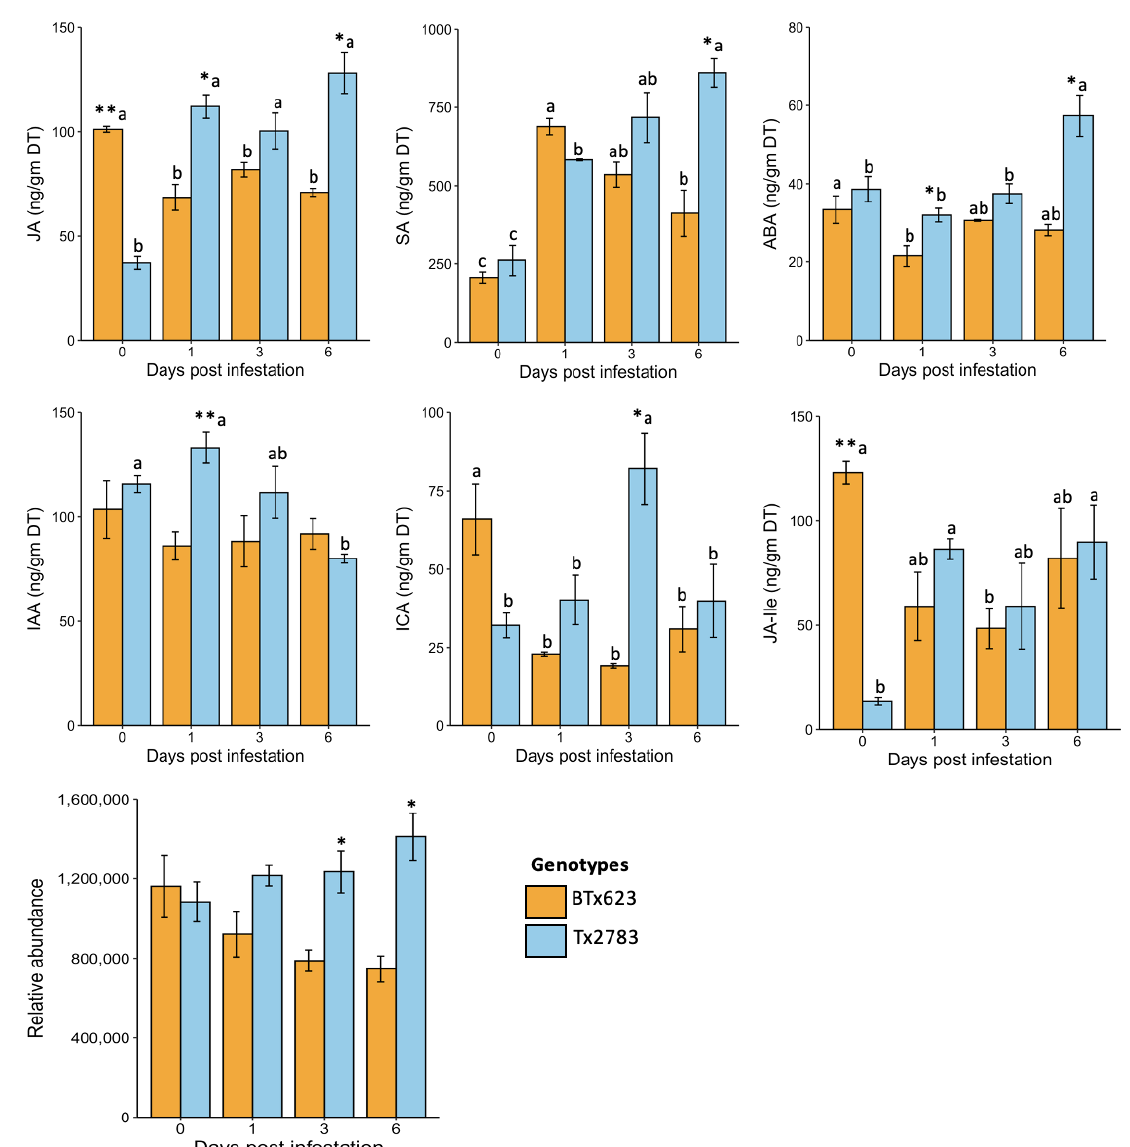
Figure 3. Constitutive levels of seven phytohormones in resistant (Tx2783) and susceptible (BTx623) genotypes during SCA infestation at different time points. The asterisk (*) at the top of each bar represents the significant difference between the genotype at same time points (* p < 0.05, ** p < 0.01; t -test). The letters at the top of each bar represent significant difference between time points within a same genotype ( p < 0.05; one-way ANOVA). (Error bars represent the mean ± SE ( n = 3).